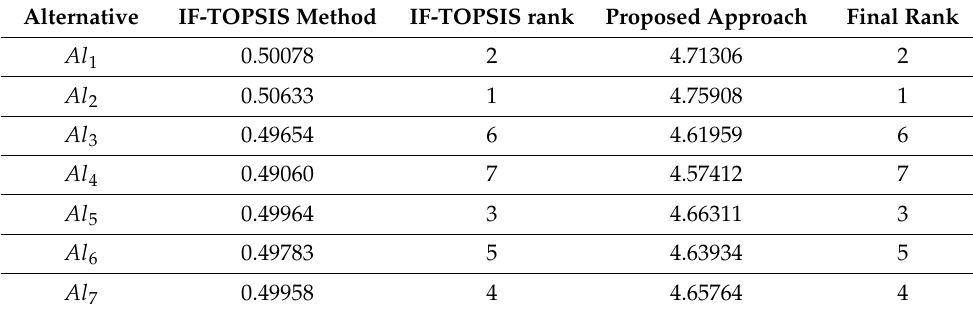
Table 16. Performance of the proposed method.